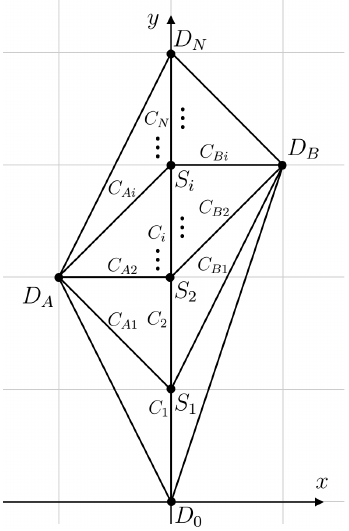
Figure 1 . The toric diagram for pure SU( N )